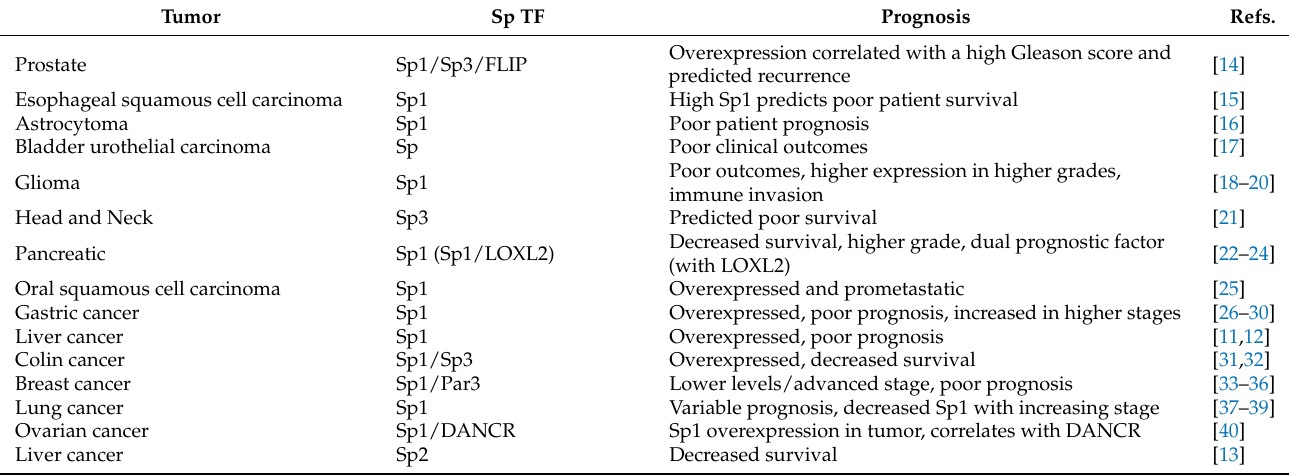
Table 1. Clinical/prognostic Significance of Sp transcription